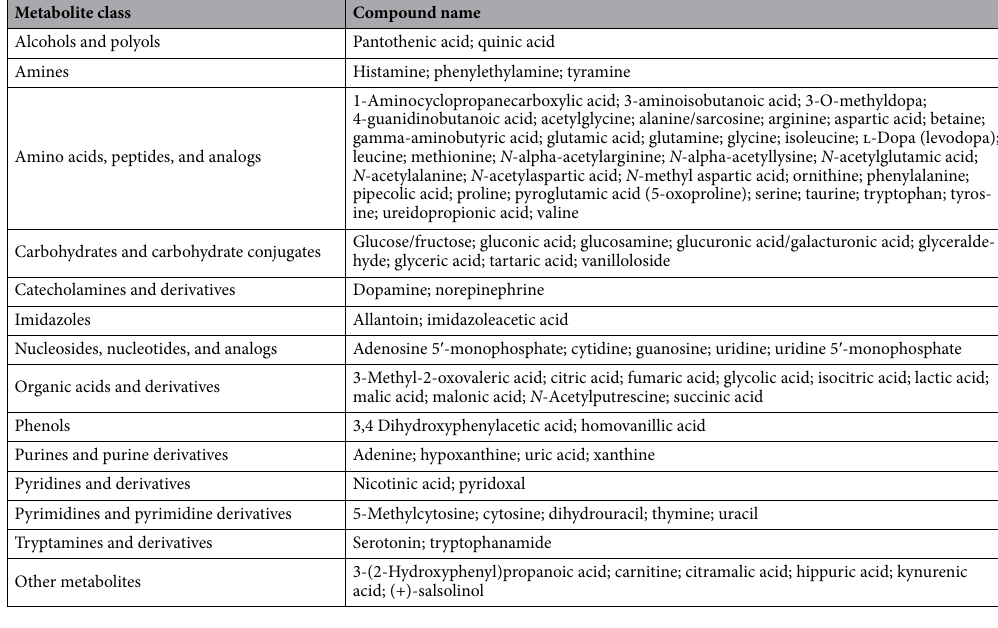
Table 1. A list of low-molecular-weight compounds identified in honeybee venom solutions in the untargeted metabolomics